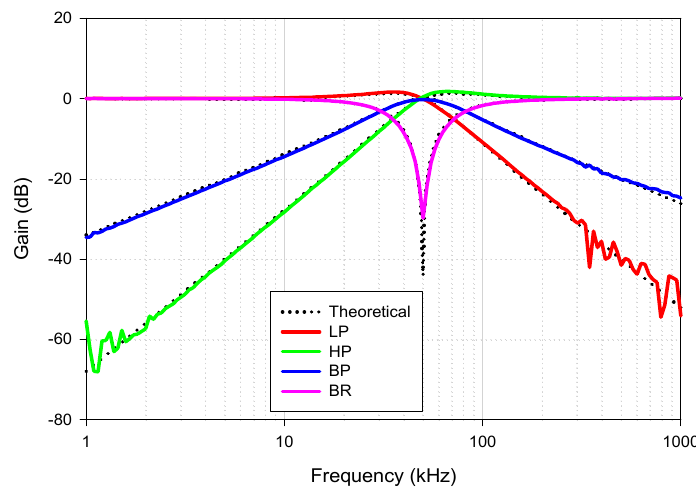
Figure 20. Experimental frequency characteristics of the proposed universal filter.